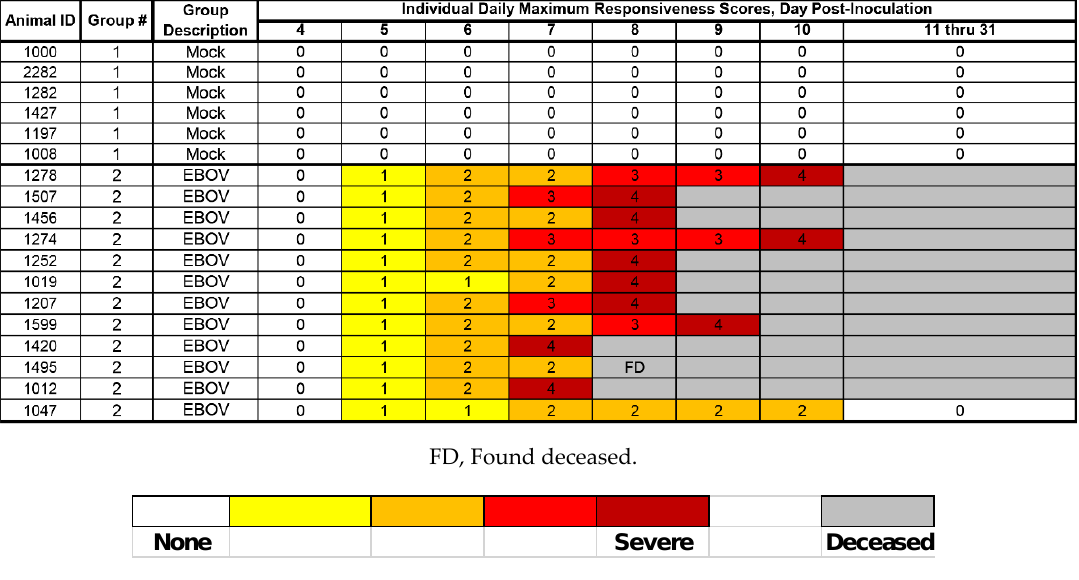
Figure 2. Daily maximum responsiveness scores.